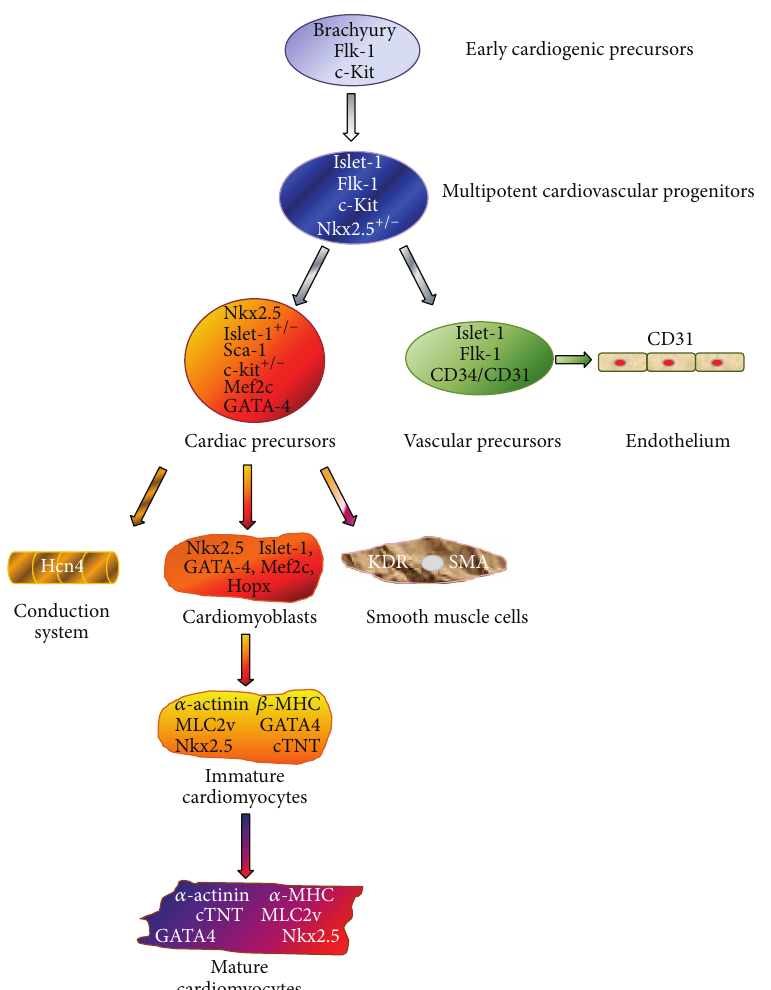
Figure 1: Cardiovascular cell lineage. Schematic representation depicting the origin of cardiomyocytes and endothelial and smooth muscle cells, as well as the conduction system. Several proteins are associated with the different stage of differentiation of the cardiac cells: islet-1, Flk-1, and c-kit are expressed at an undifferentiated stage, whereas the expression of Nkx2.5 and Sca-1 identifies more differentiated cardiac precursor